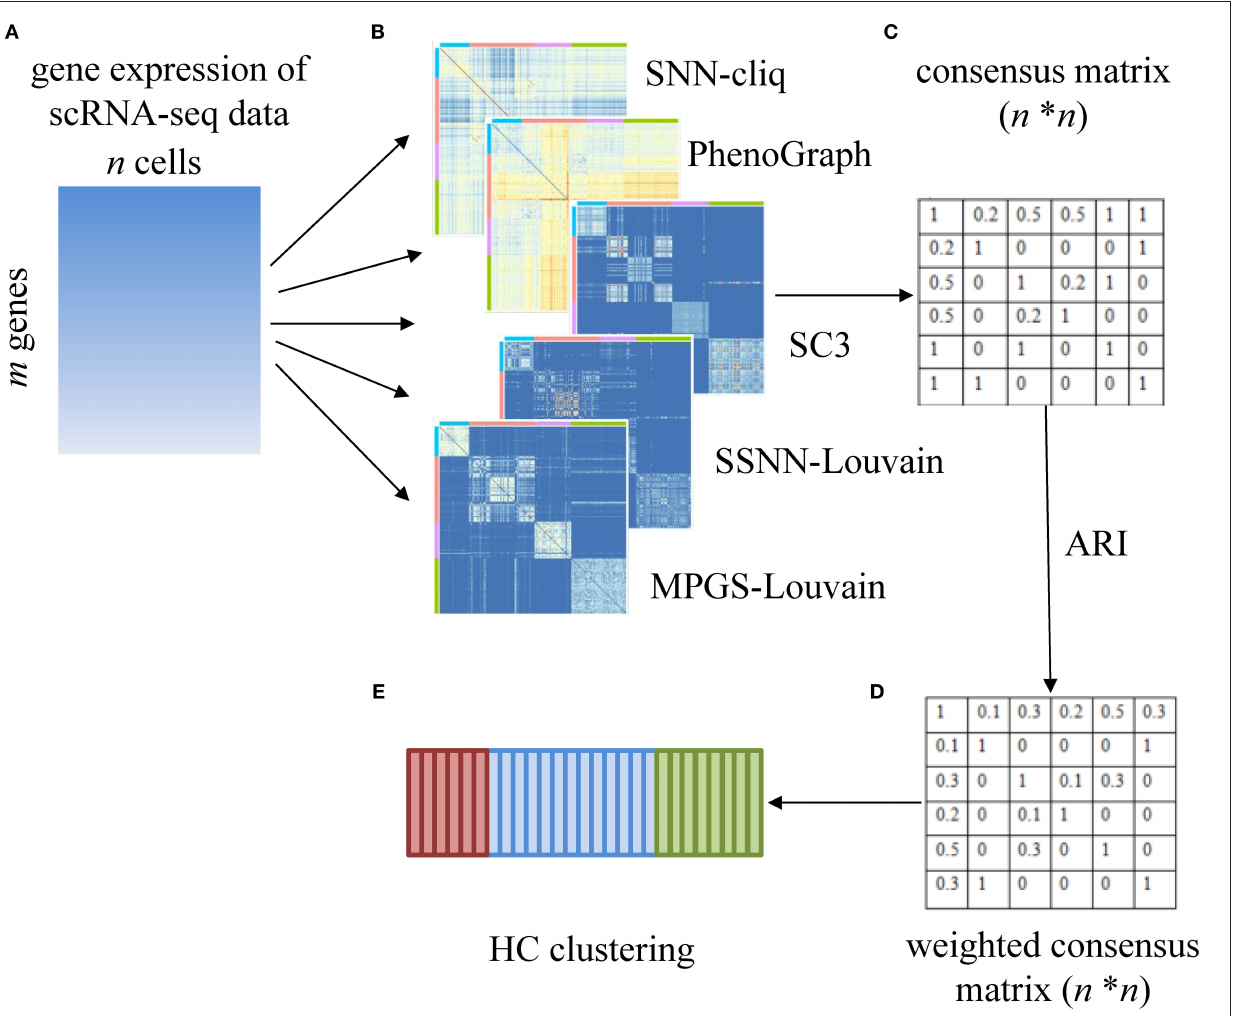
FIGURE 1 | The overview of the Sc-GPE method. (A) The gene expression matrix is input; (B) five individual clustering methods are performed to generate five clustering solutions; (C) the original consensus matrix is constructed; (D) the weighted consensus matrix is produced by measuring the importance of the individual clustering methods; (E) HC clustering is